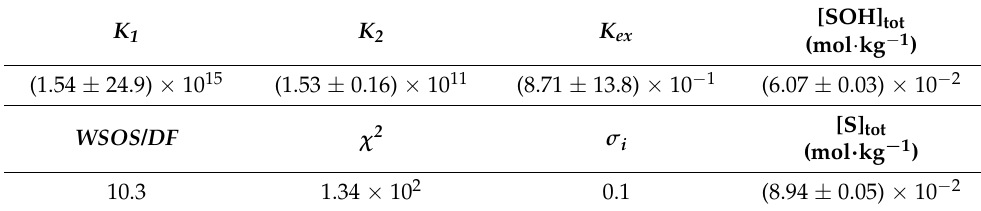
Figure 1. BCS experimental and calculated titration curves: ( a ) surface charge, Q = f(pH), ( b ) mol fractions, F = f(pH), of edge (SOH 2+ , SOH 0 , SO − ) and layer (XNa) sites. Table 4. Calculated model parameters for sample